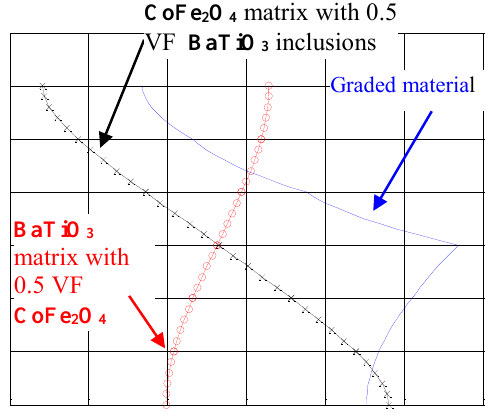
Figure 7 : Variation of the electric potential along the thickness direction in the graded material caused by a surface load on the top surface